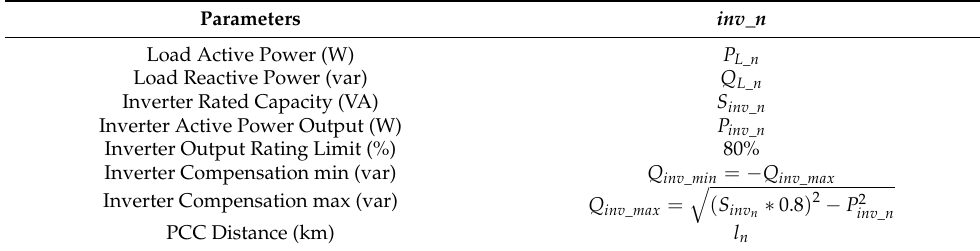
Table 1. Virtual STATCOM System